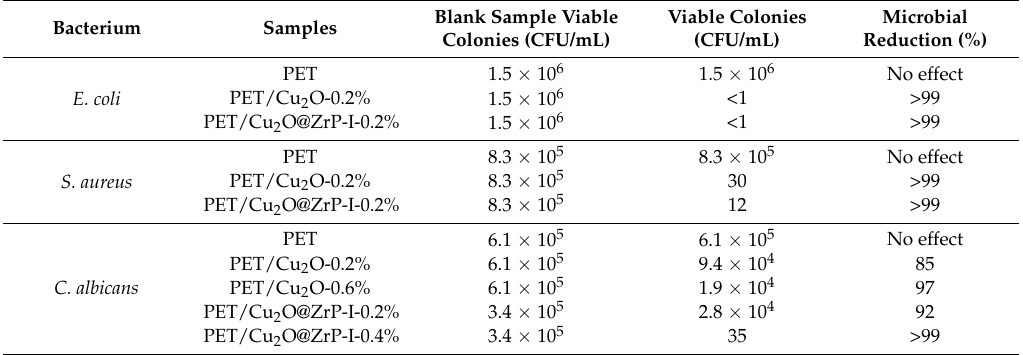
Figure S1: ( a ) SEM image and ( b ) TEM image of neat α -ZrP, Figure S2: ( a ) XRD patterns of ZrP and Cu 2 O@ZrP. ( b ) Cu 1p XPS spectra of Cu 2 O@ZrP, Figure S3: SEM images of neat PET fibers, Figure S4: GPC curve